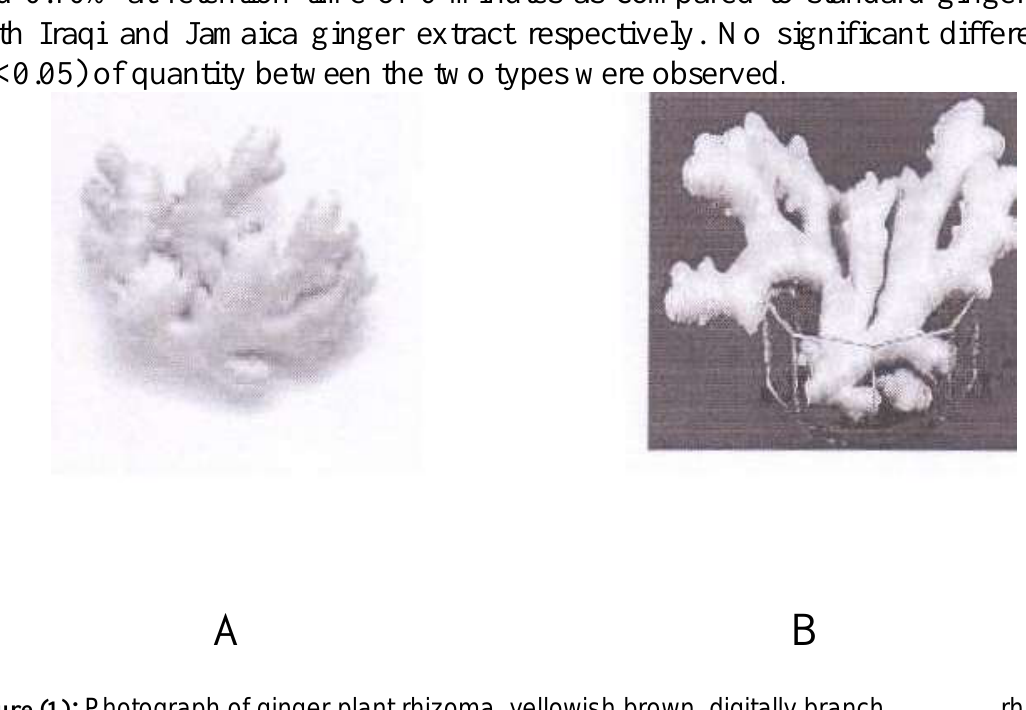
Figure (1) : Photograph of ginger plant rhizoma, yellowish brown, digitally branch rhizoma A. Iraqi cultivated ginger. B. Jamaica cultivated ginger.